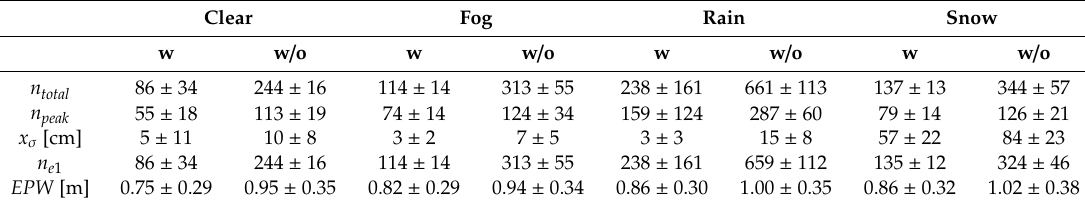
Table 3. Most important parameters for the atmosphere region (0–5 m)*. (w / o) Without background radiation, (w) with background radiation. With n total : total number of detections in the region, n peak : number of detections in the maximum, x σ : standard deviation of the detection